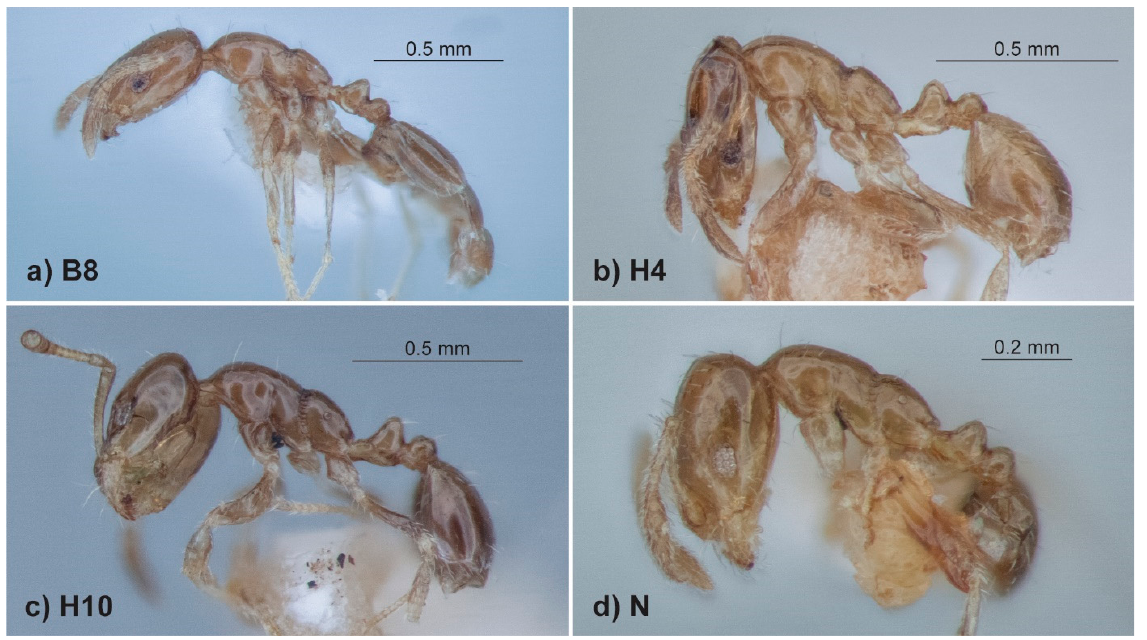
Figure 8. Images of species from the ‘sp. 13’ morphotype. ( a ) Specimen OZBOL1330-21; Maryfield Stn, NT; ( b ) specimen MONM594-18; Mt Elizabeth, WA; ( c ) MONOM595-18; Cascade Ck, WA; ( d ) specimen DARW206-15; Theda Stn, WA.